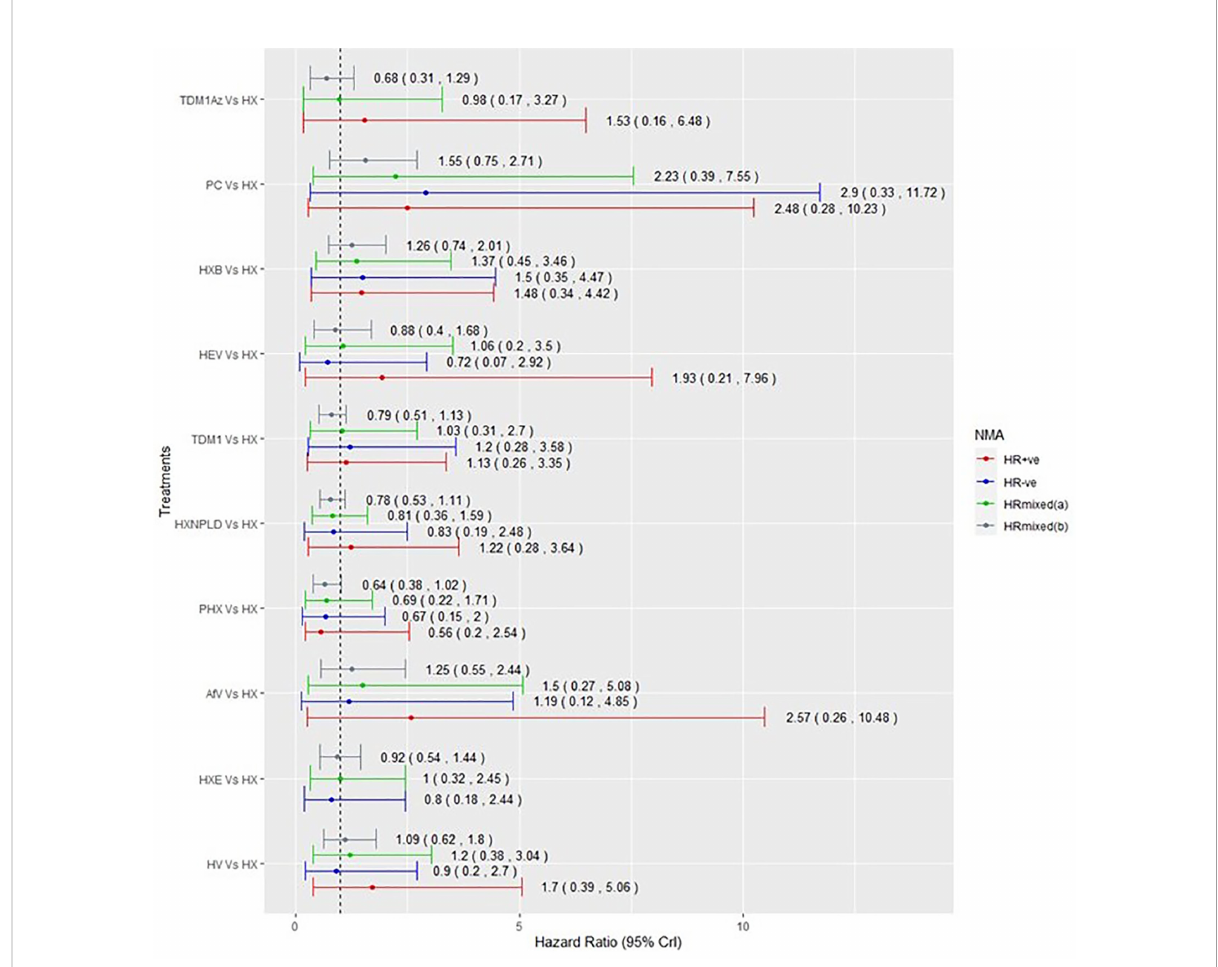
FIGURE 5 Comparative summary forest plots of treatment effects obtained from the HX connected network for PFS. PC, physician choice; LC, lapatinib + capecitabine; TDM1, trastuzumab emtansine; TDM1AZ, trastuzumab emtansine + atezolizumab; HX, trastuzumab + taxane; HXB, trastuzumab + taxane + bevacizumab; LX, lapatinib + taxane; HV, trastuzumab + vinorelbine; HXE, trastuzumab + taxane + everolimus; PHX, pertuzumab + trastuzumab + taxane; AfV, afatinib + vinorelbine; HEV, trastuzumab + everolimus + vinorelbine; HXNPLD, trastuzumab + taxane + NPLD; NPLD, non-pegylated liposomal